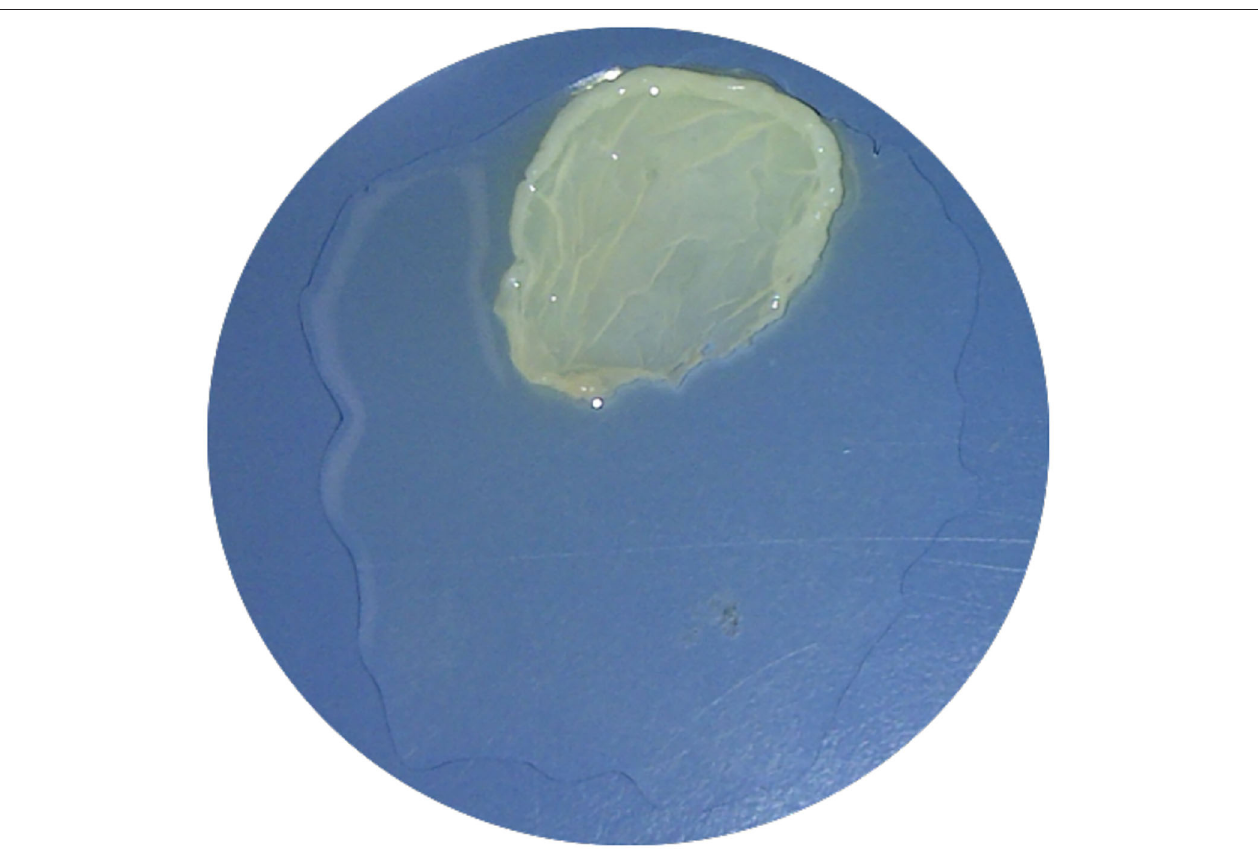
FIGURE 3 | Coin-shaped PRFM produced via centrifuging PRP in a Wheaton bottle.